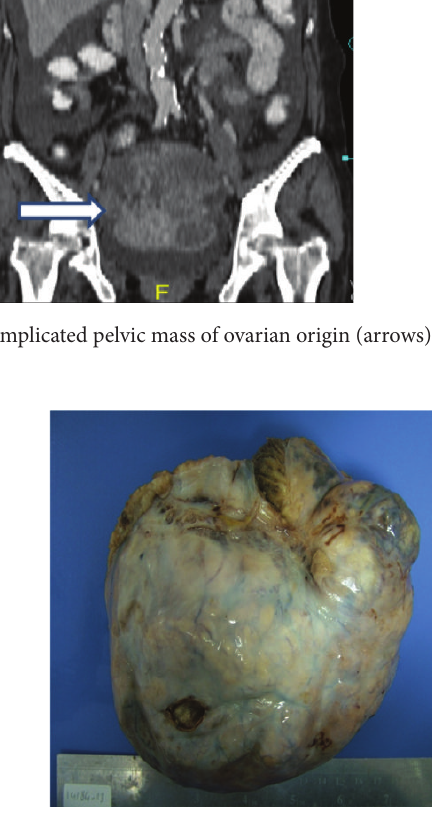
Figure 2: Pelvic mass of ovarian origin after